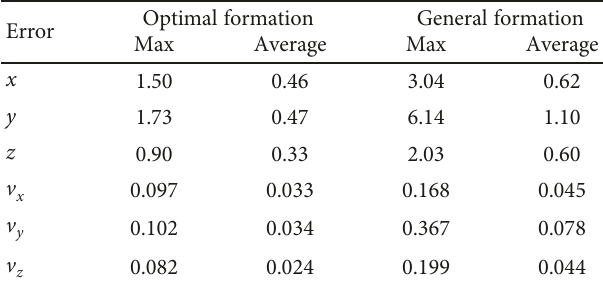
Table 4: The max and average estimation errors. Optimal Error